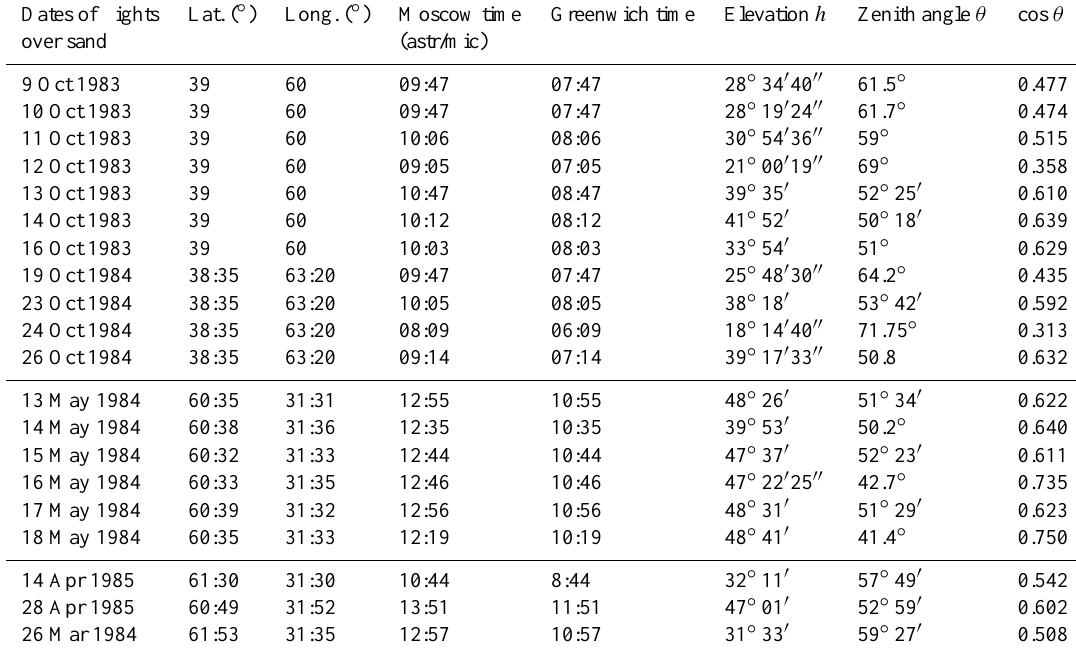
Table 1. Dates, time, solar elevation and locations of the flights implemented over sand, water and snow. Dates of flights Lat. ( ◦ ) Long. ( ◦ ) Moscow time over